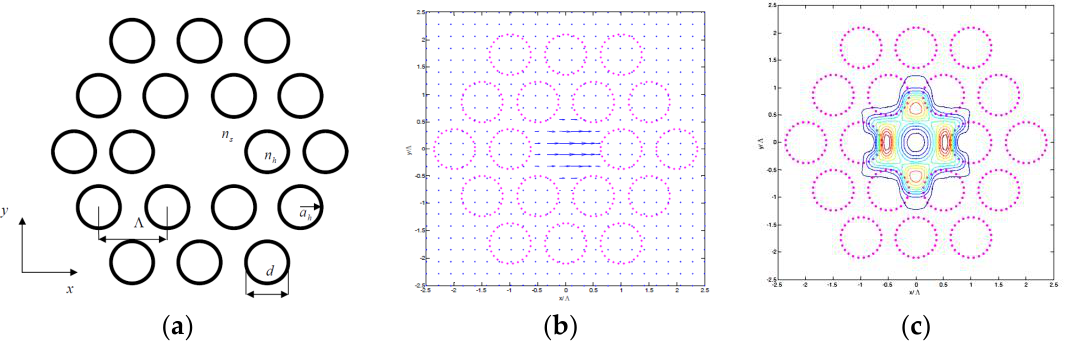
Figure 1. ( a ) Schematic of the solid-core photonic crystal fiber (PCF) with two air-hole rings, where Λ is the air-hole pitch, d is the air-hole diameter, and the background material is silica. ( b ) The transverse magnetic-field vector distribution of the real part, and ( c ) the field intensity distribution of the imaginary part of HE 11 mode (fundamental mode) for the PCF with 2 air-hole rings (18 air-holes).